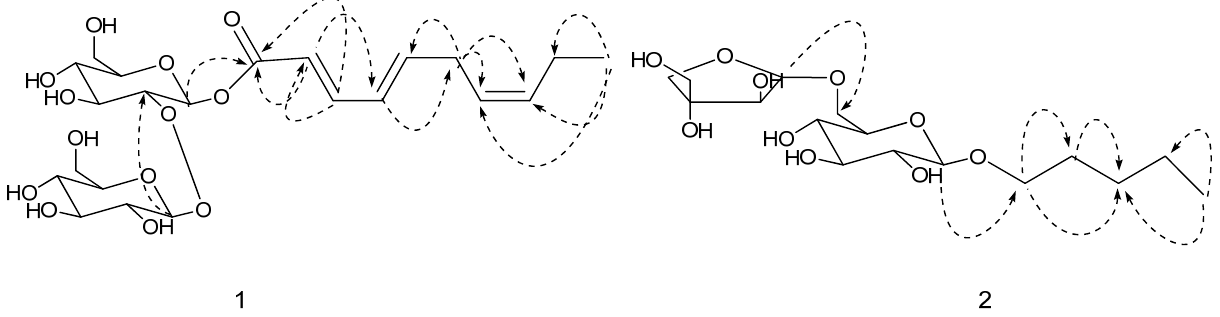
Figure 2. Key HMBC correlations of 1 and 2